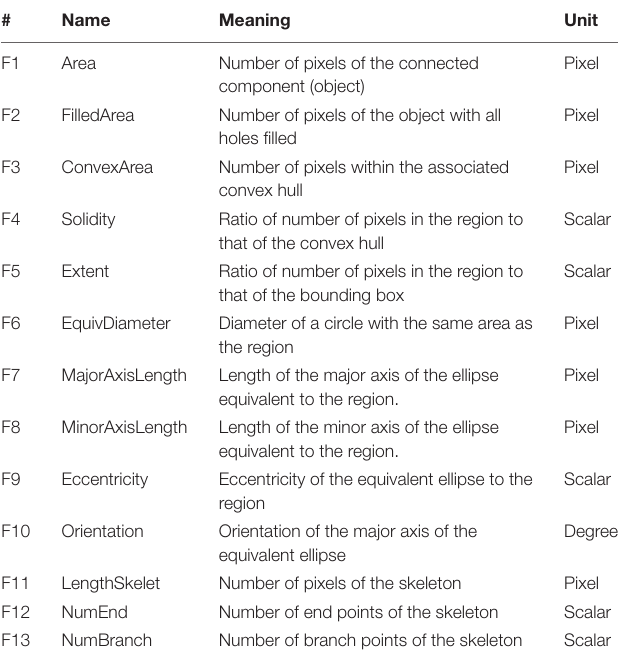
TABLE 2 | The 13 features extracted for each of the connected object.